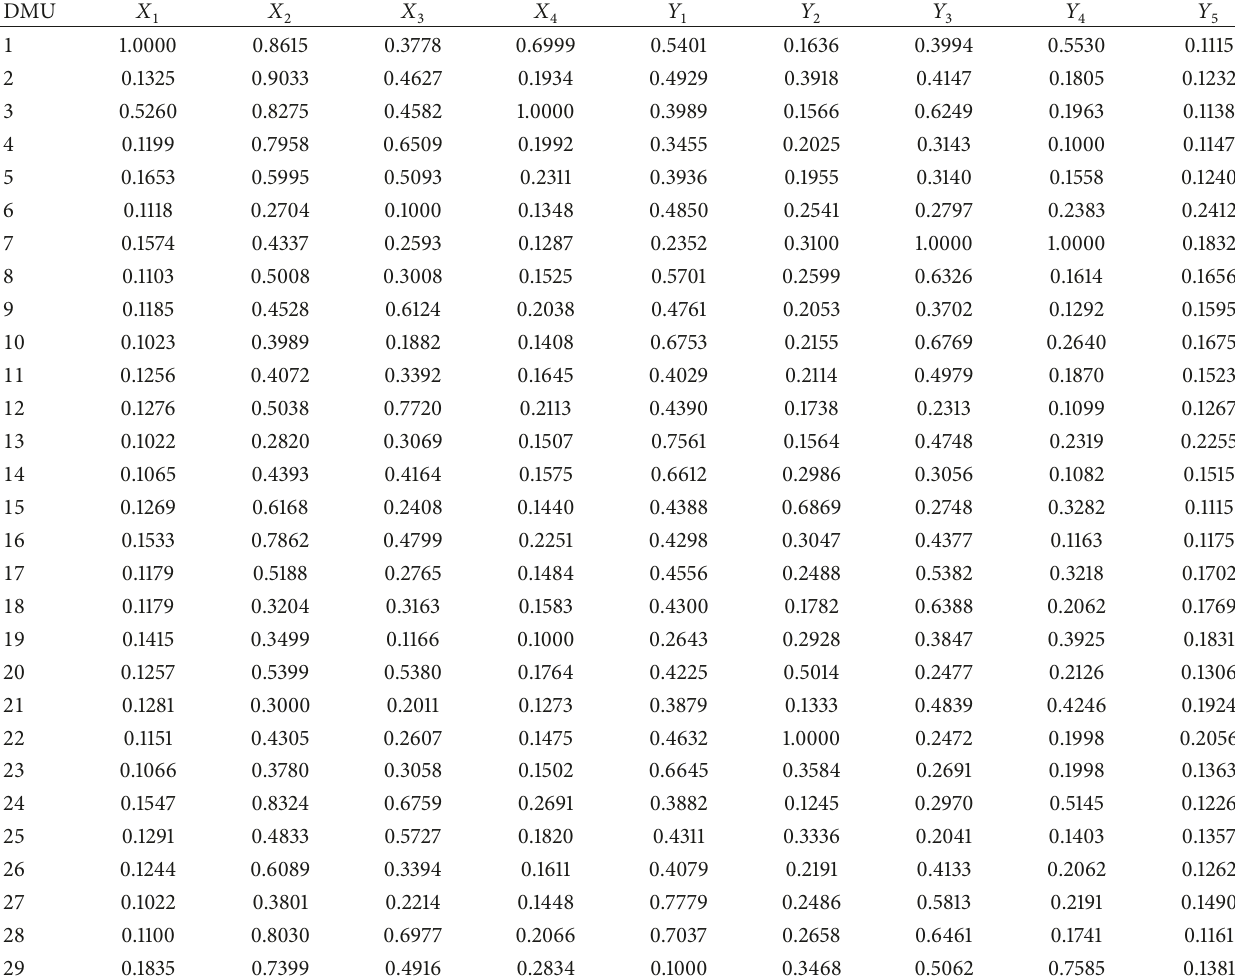
Table 4: Data for twenty-nine DMUs with three inputs and three